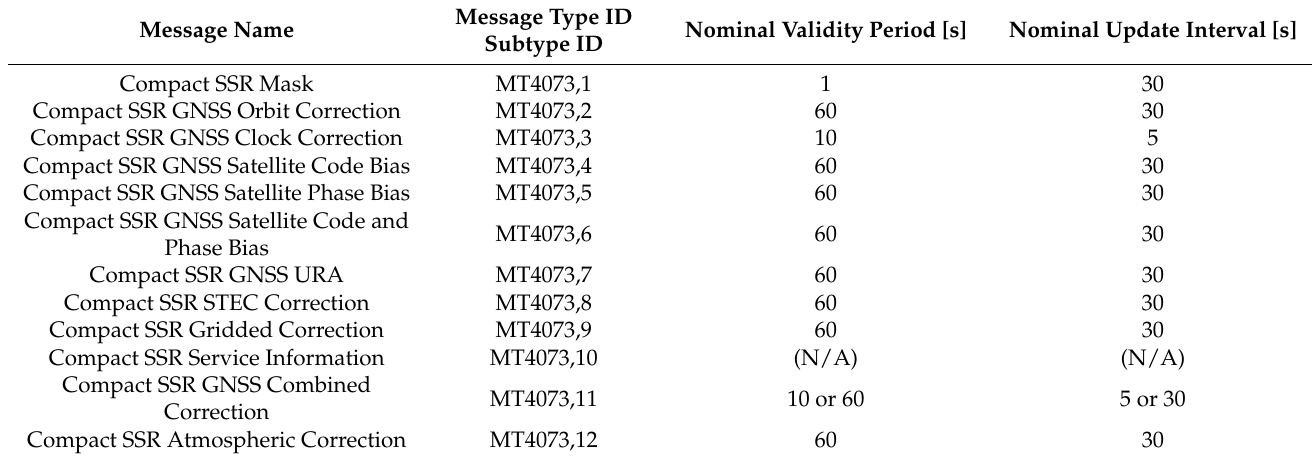
Table 1. Compact SSR message type, nominal validity period, and nominal update